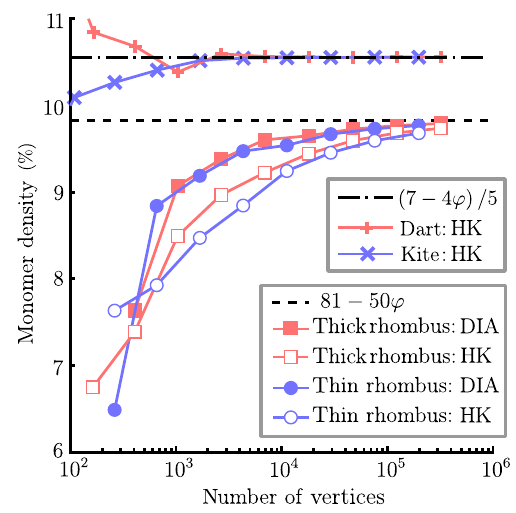
FIG. 13. Numerical results for the density of monomers in finite sections of the Penrose tiling. To achieve results with the least possible bias, we consider inflations of each basic tile: the thick (red squares) and thin (blue circles) rhombuses for P 3 and the dart (red crosses) and kite (blue crosses) for P 2 (see Sec. VII). For the rhombic tiling, solid symbols correspond to systems in which monomers are placed according to the dimer inflation algorithm (DIA) of Sec. IVA, whereas hollow symbols correspond to systems in which maximum matchings are found using the Hopcroft-Karp algorithm (HK, also used for the dart-kite tiling). The analytical results of 81 − 50 φ ≈ 0 . 098 for the rhombic P 3 tiling and ð 7 − 4 φ Þ = 5 ≈ 0 . 106 for the dart-kite P 2 tiling are shown by the black dashed